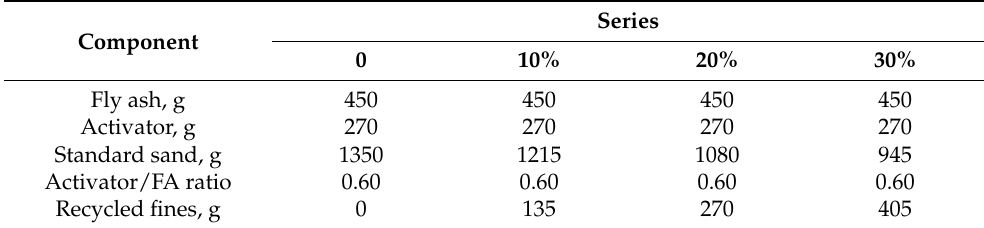
Table 6. The composition of the geopolymer mortars based on the content of recycled fines (on